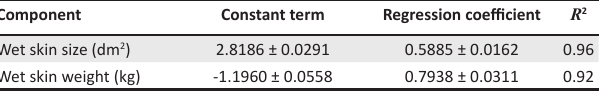
TABLE 5: Allometric equations relating the natural logarithms of the wet skin size and weight to the natural logarithms of the empty body protein weight (kg). Component